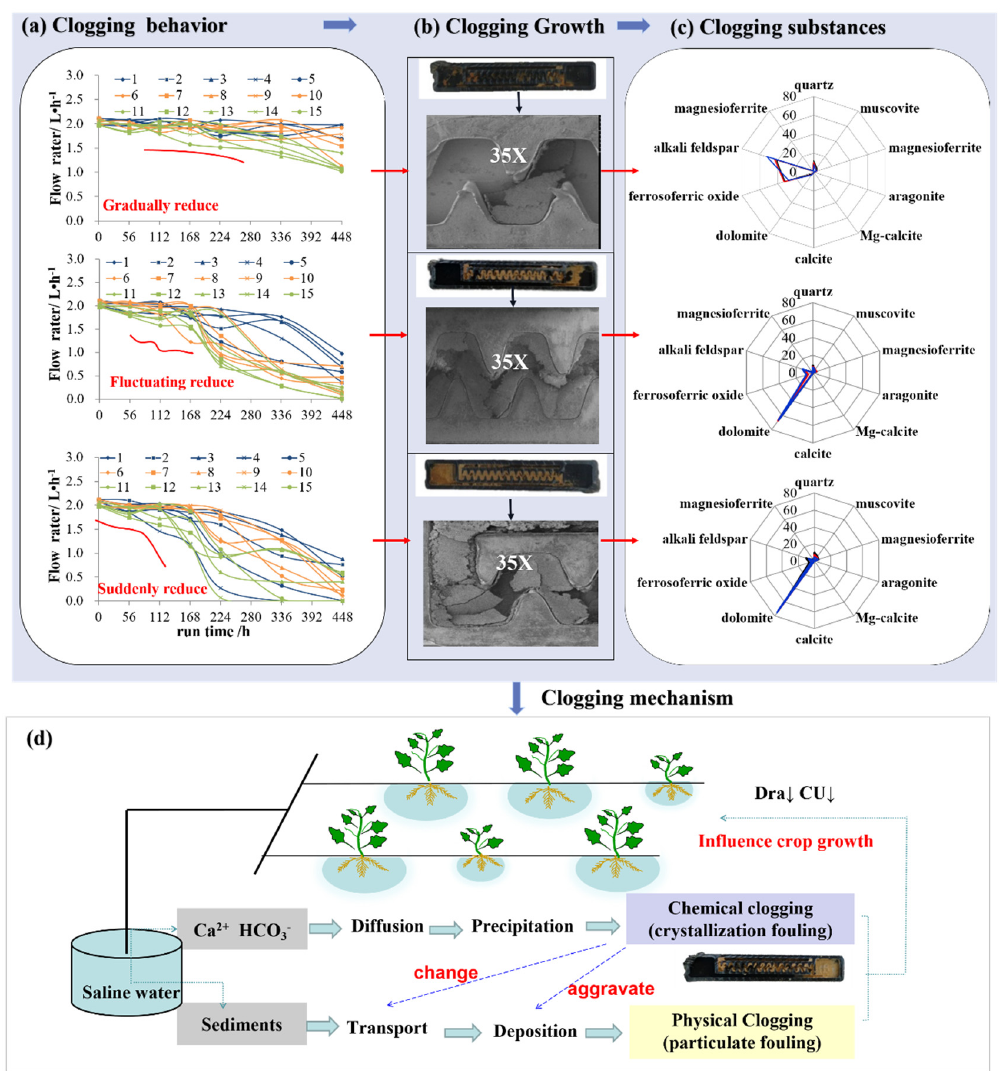
Figure 6. The clogging behavior, growth, substances, and mechanism drip irrigation system using saline water. ( a ) The dynamic process of chemical clogging under the salinity levels